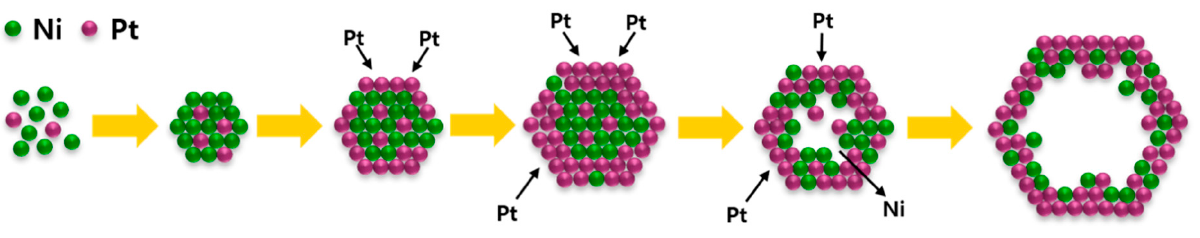
Figure 6. Schematics of the hollow PtNi nanoparticles.